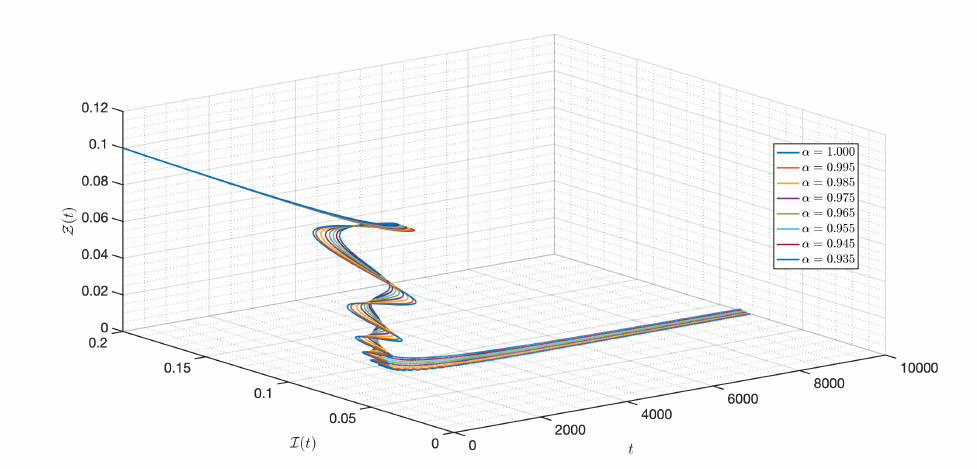
Figure 44. Dynamic of the model (3) for different parameters in Case IV